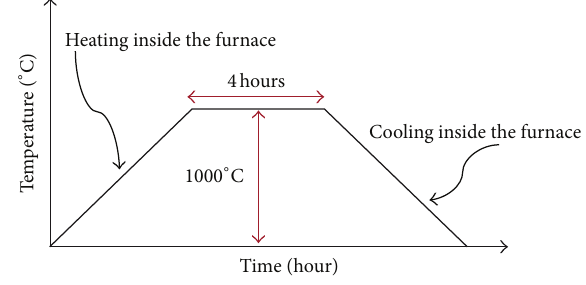
Figure 2: Schematic curve of hot corrosion cycles at 1000 ∘ C.